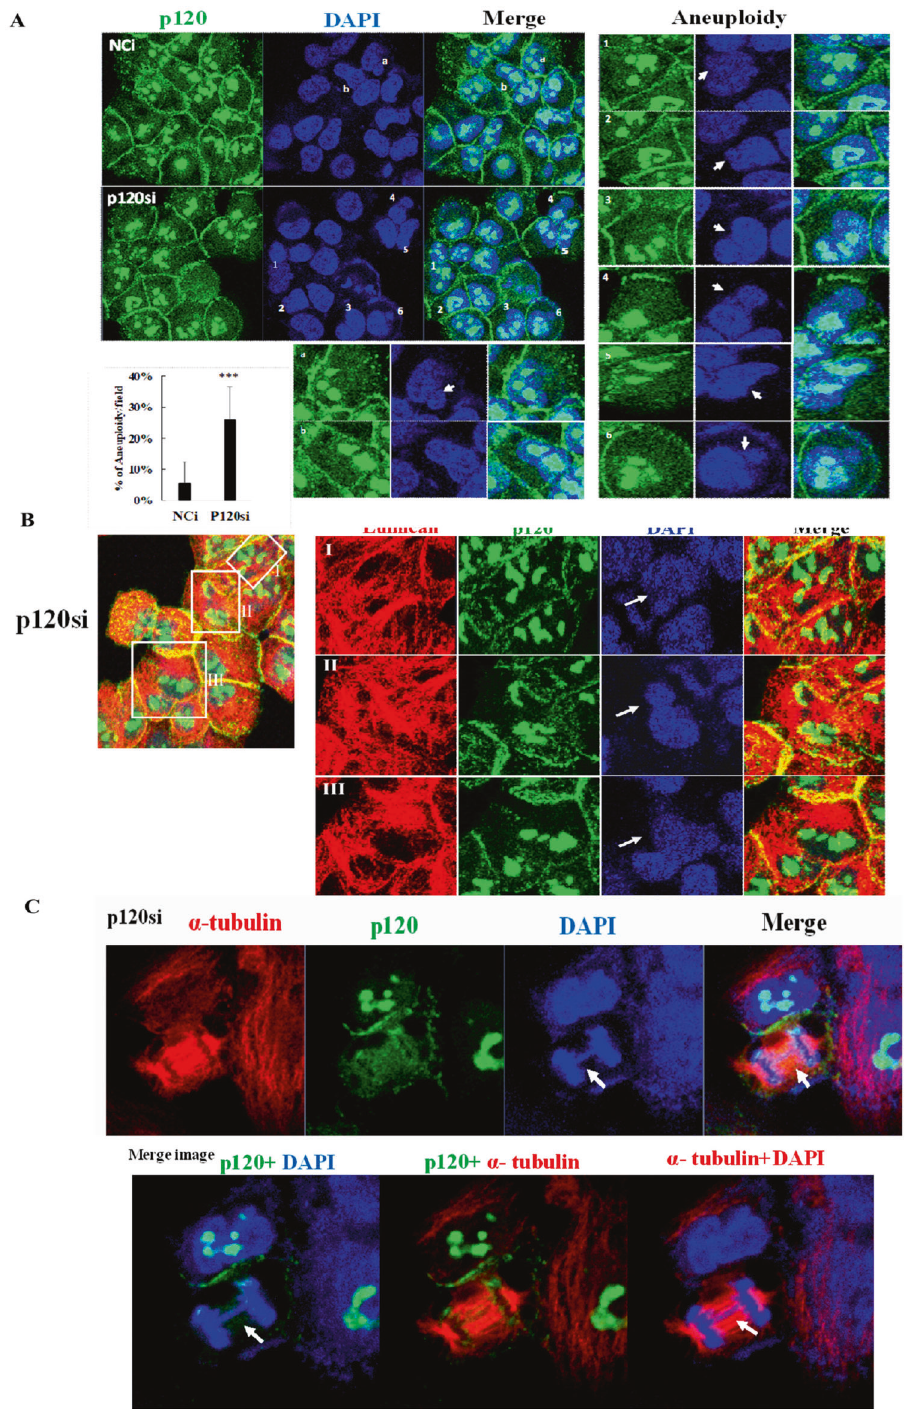
Fig. 5 Downregulation of p120 catenin induces aberrant mitosis. P120 siRNA-transfected cells were stained using anti-p120 catenin and anti-lumican antibodies and DAPI to visualize the cell boundary and nuclei, respectively. A Multi-nucleated cells immunostained using the anti-p120 catenin antibody (green) and DAPI. Representative images of micro-nuclei/aneuploid cells (marked by the white arrows) in NCi- and p120si-transfected H460 cells. The letters and numbers in the panel represent the images captured in the multi-nucleated cells. Multi- nucleated cells are quanti fi ed in the lower panel. B Micronuclei were detected in p120si-transfected cells. C Immunostaining with anti-p120 (green) and anti- α tubulin (red) antibodies revealed a p120si-transfected cell with a chromatin bridge (indicated by an arrow) during